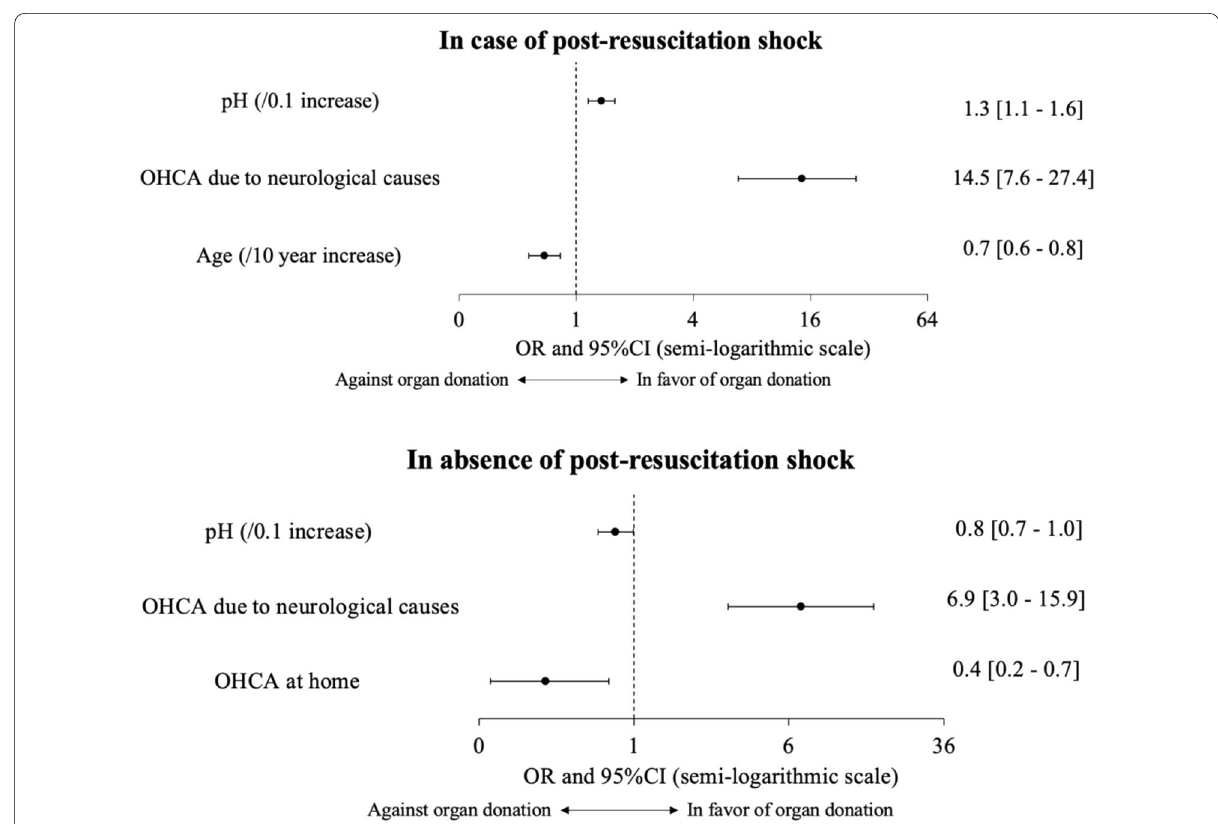
Fig. 4 Significant independent predictors of organ donation in patients with and without post-resuscitation shock. Only patients without missing data were included; 95% CI: 95% confidence interval; OHCA: out-of-hospital cardiac arrest; OR: odds